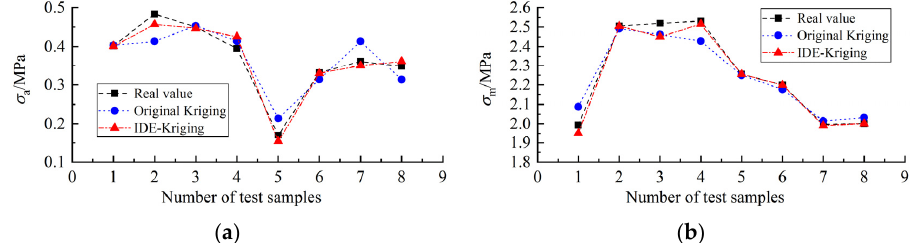
Figure 17. Comparison of prediction results of the first-layer Kriging surrogate model: ( a ) surrogate model of σ a ; ( b ) surrogate model of σ m